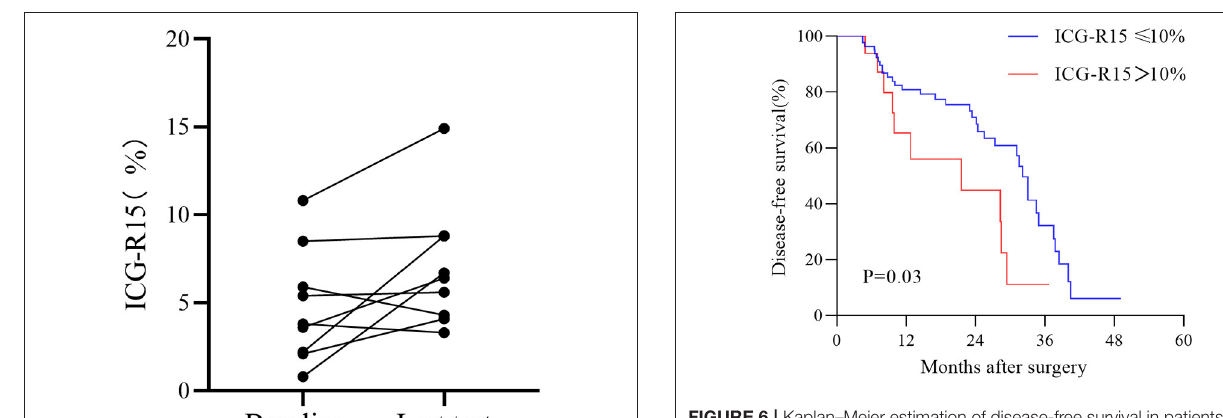
FIGURE 6 | Kaplan–Meier estimation of disease-free survival in patients with hepatocellular carcinoma (HCC) according to the stratification of